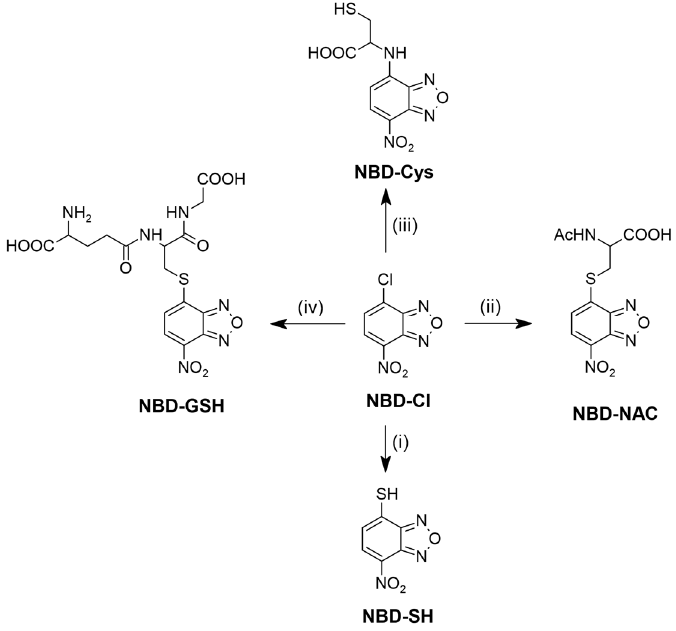
Scheme 3. Synthesis of NBD-derived compounds. Reagents and conditions: ( i ) Na 2 S, MeOH, room